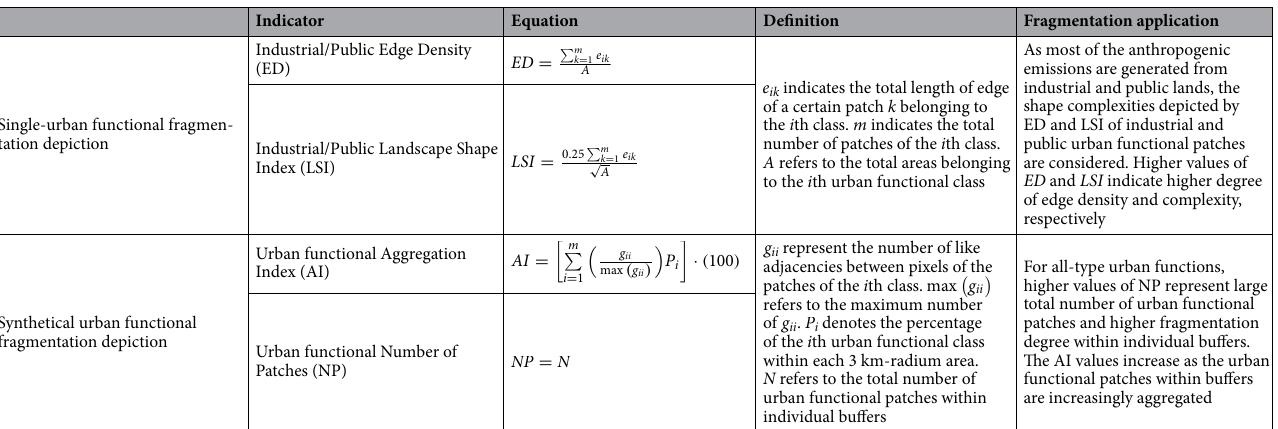
Table 2. Indicators for depicting urban functional